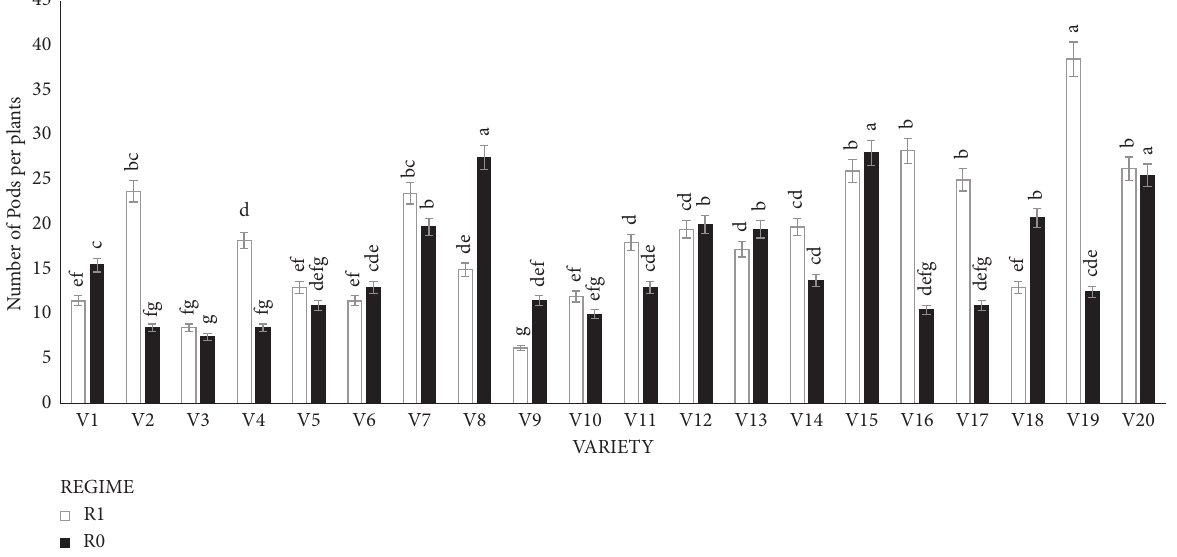
Figure 2: Effect of drought stress on the number of pods at the vegetative Table 2: Average physiological parameters under drought stress at reproductive phase.